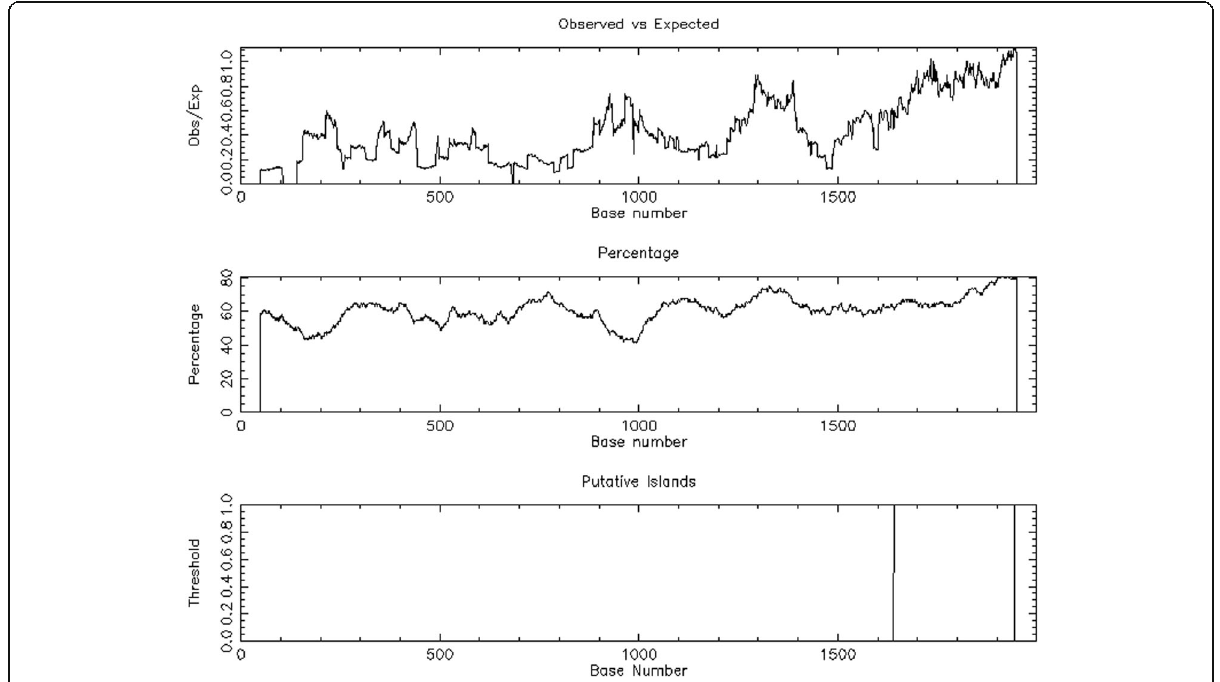
Fig. 11 Methylated CpG island map in the promoter region of the human PRRT2 gene predicted by the EMBOSS software